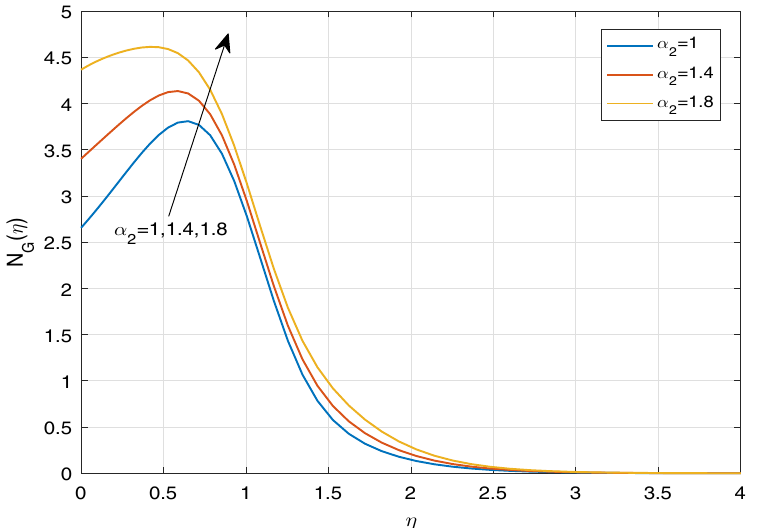
Figure 23. Sketch of N G against α 2 .